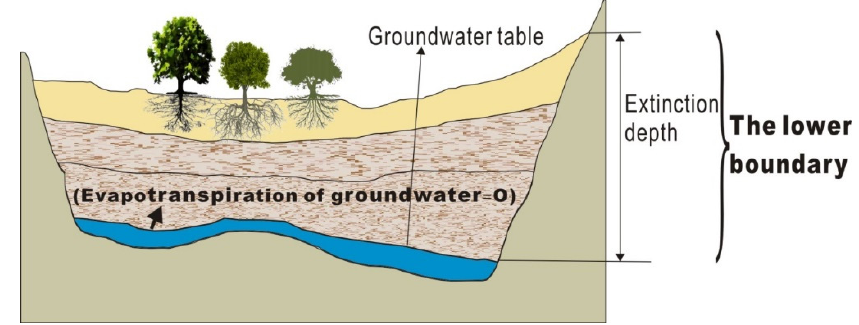
Figure 5. Diagram showing the conceptual lower groundwater boundary that is crucial to the stability of a present vegetation